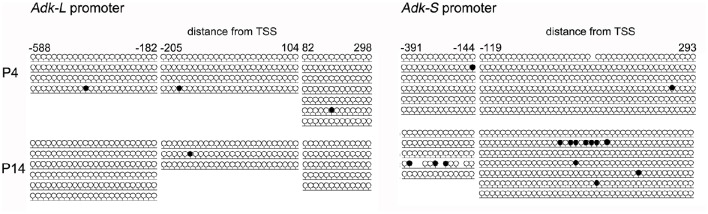
DNA promoter methylation. CpG methylation was analyzed using bisulfite sequencing following amplification and subcloning of the region of interest. A minimum of three clones was analyzed per sample. Promoter regions were amplified from pos. −588 to +298 (long isoform) and pos. −391 to +293 (short isoform) relative to TSS.